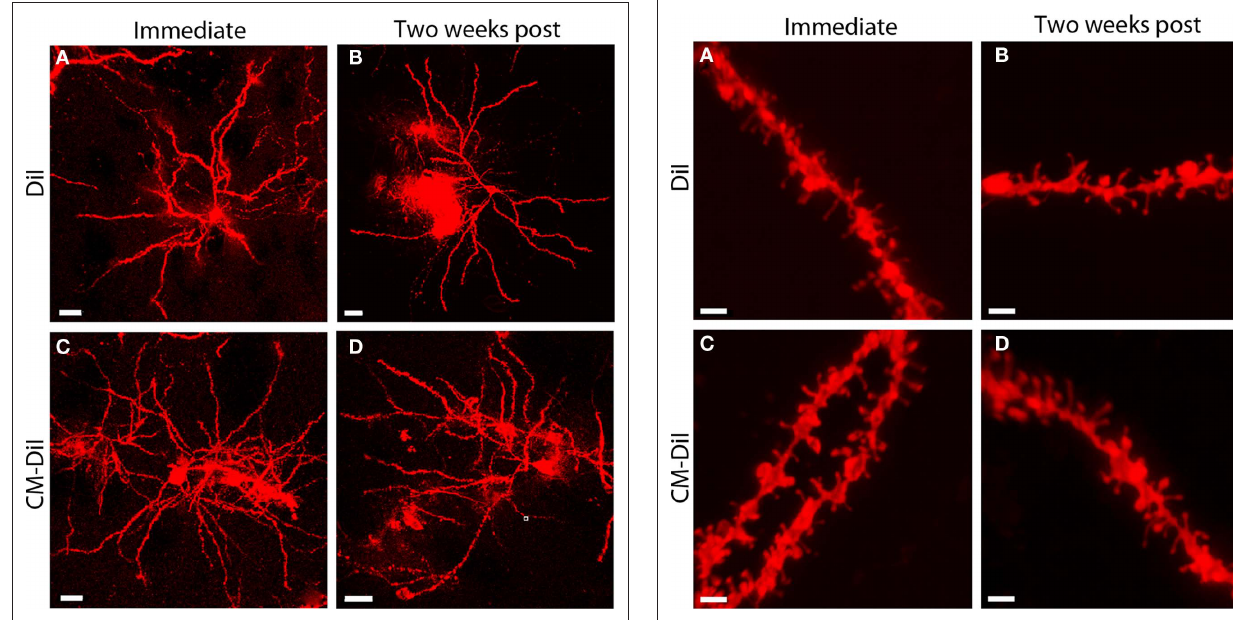
Figure 1 | Whole cell images of non-permeabilized Dii and CM-Dii labeled tissues. DiI labeled cell imaged (A) immediately or (B) 2 weeks following tissue mounting. CM-DiI labeled cell imaged (C) immediately or (D) 2 weeks following tissue mounting. Images illustrate micro-carrier clumps commonly seen with DiOlistic labeling. Scale bar is 20 μm.